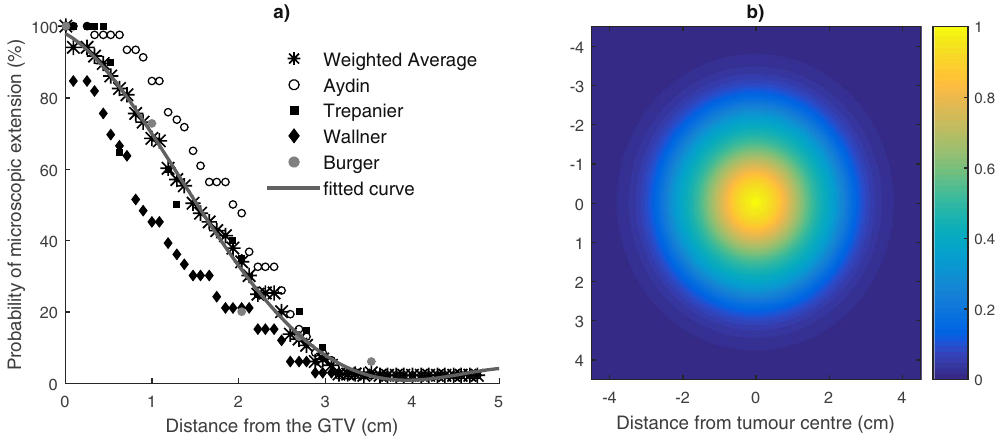
Figure 2. ( a ) Clinical studies investigating the extent of microscopic extension in GBM patients. The function fitted to combined results (a three-term Gaussian function) was considered as the basis for the MEP models; ( b ) Isotropic circular MEP distribution; courtesy of Moghaddasi et al . 35 .